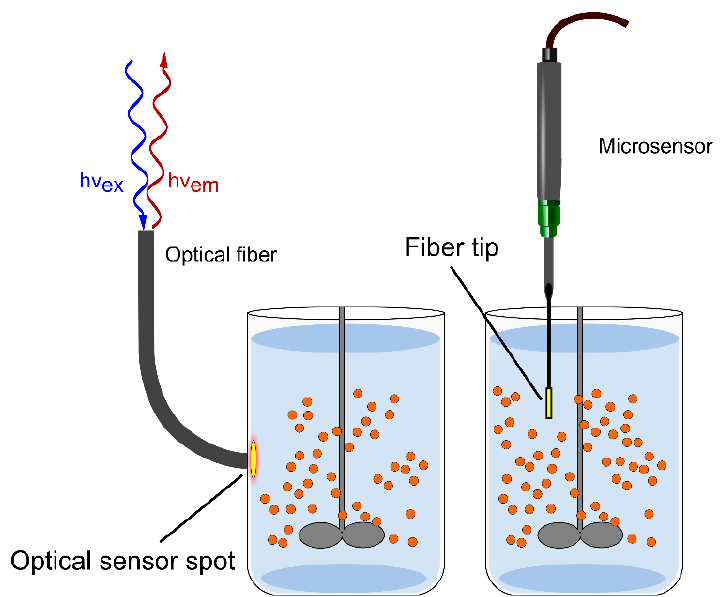
Figure 2. Optical sensing in solution. An integrated sensor spot (left) or a microsensor (middle) can be used for the determination of pH, O 2 and other analytes. The figure was adapted from reference [14] with permission from Elsevier.